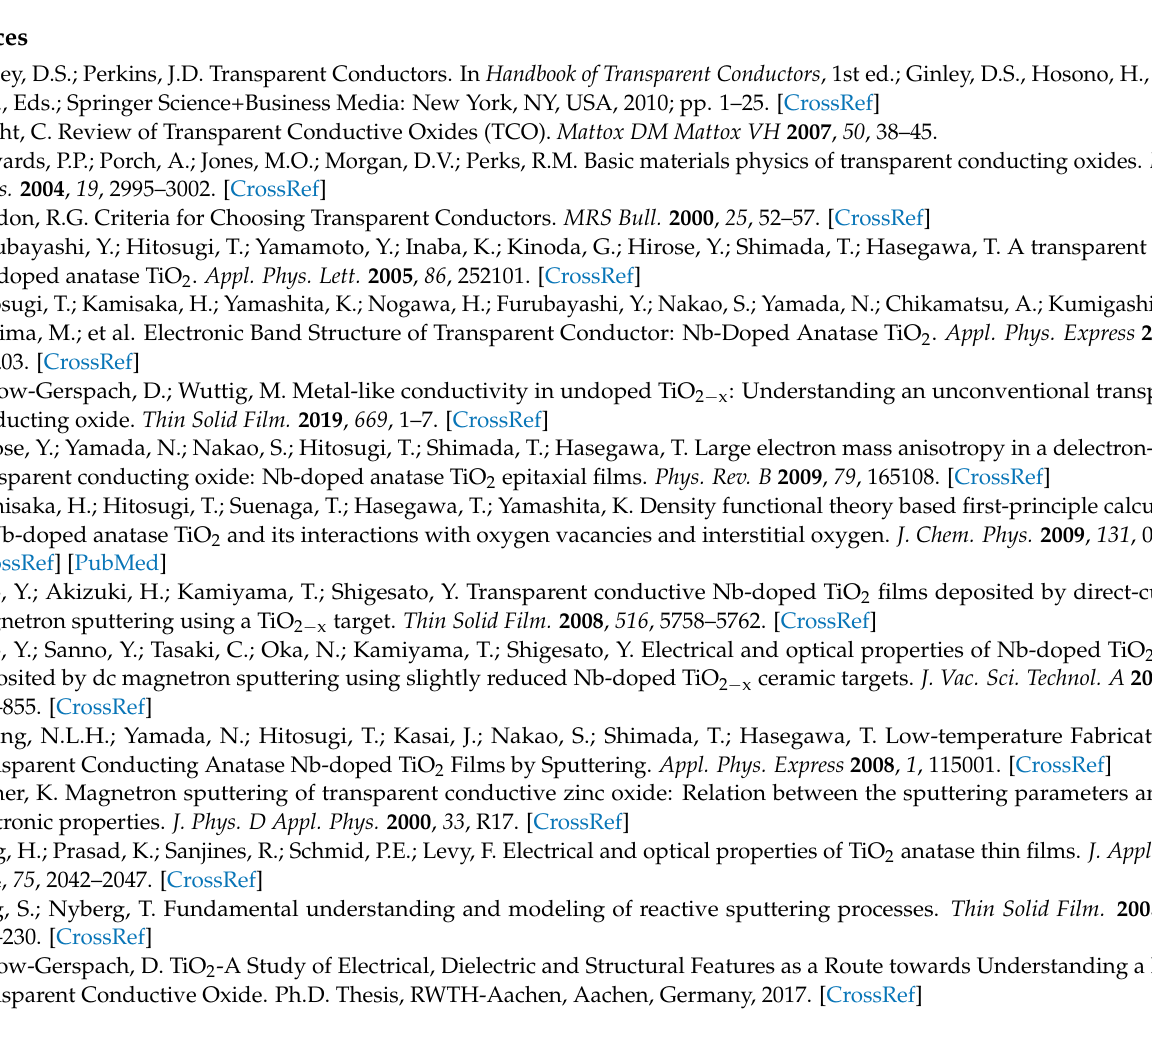
Figure A2. XRD in grazing incident geometry of Nb-doped films sputtered at different O 2PP levels, after annealing at 300 ◦ C for 2 h. Only anatase reflexes are found and films with insufficient oxygen content remained amorphous, which was previously reported for undoped TiO 2 − x